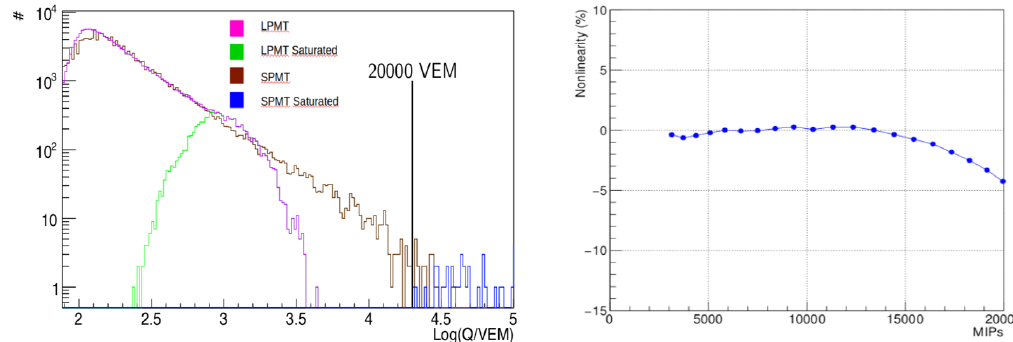
Figure 2. Left: Charge spectrum in one of the upgraded WCD stations, as measured by the large PMTs (pink: unsaturated, green:saturated) and by the small PMT (brown: unsaturated, blue = saturated). Right: Linearity behaviour of one of the SSD-PMT.